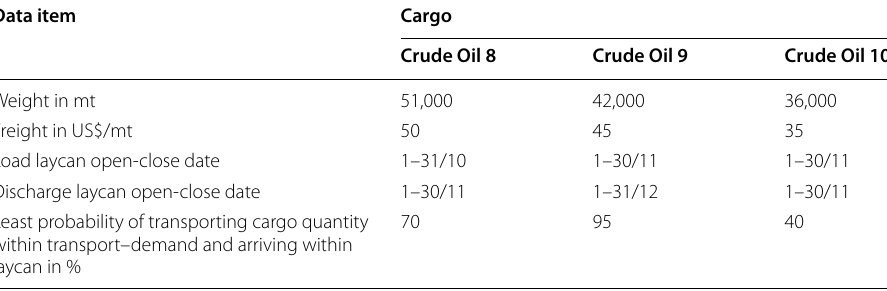
Table 6 Unconfirmed cargo deterministic-equivalent quantity, freight, and laycan Data